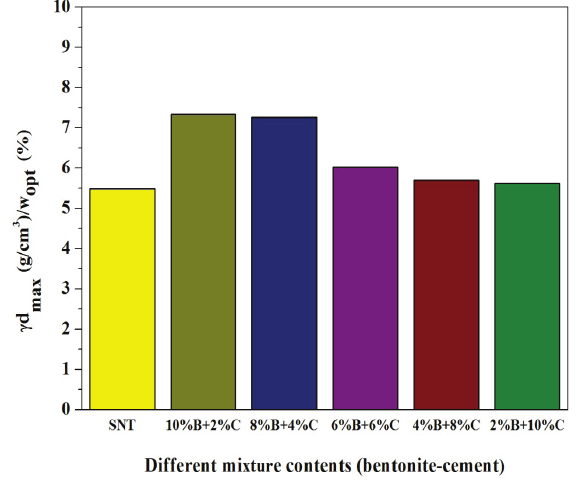
Figure 3: Variation